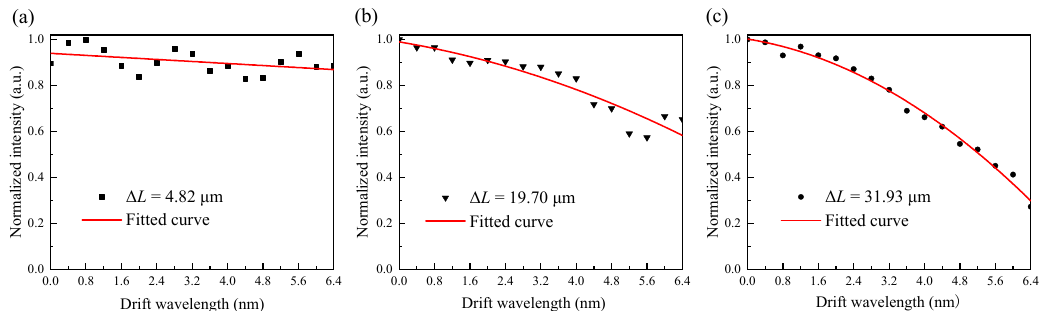
Figure 15. Q–FFPM–DCM demodulated signal intensity with wavelength drift for fiber step heights of 4.82 μ m ( a ), 19.70 μ m ( b ), 31.93 μ m ( c ).